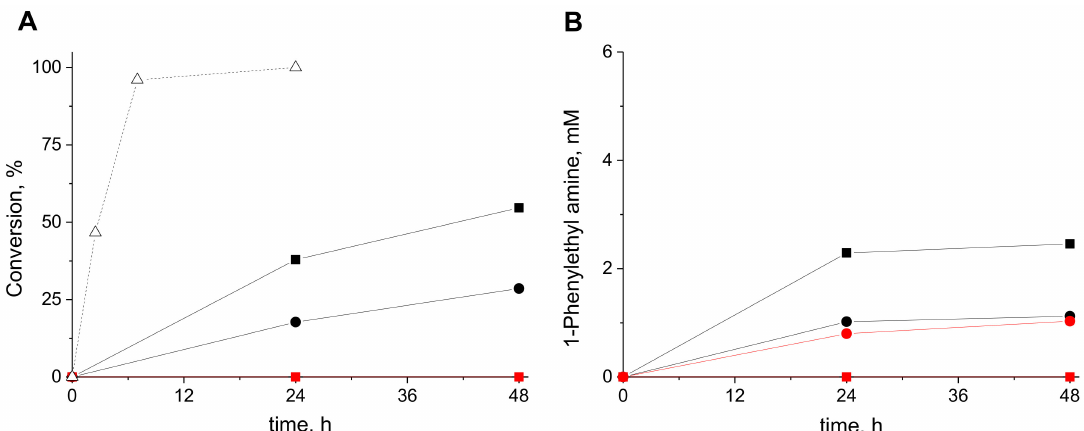
Figure 2. Results of the direct amination of 1-phenylethanol ( 5a ) in a one-pot one-step fashion with SAS ( − ) and g-C 3 N 4 ( − ) photocatalysts, employing BM ω TA ( Bacillus megaterium ω TA (cid:4) / (cid:4) ) and AT ω TA ( Aspergillus terreus ω TA • / • ) enzymes. ( A ) Conversion of 5a . As a comparison, the conversion of 20 mM 5a in MilliQ water containing 0.75 mM SAS is also shown ( (cid:52) ); ( B ) Production of 1-phenylethyl amine 5c . Reaction conditions: 1 mL reaction mixture containing sodium phosphate (NaPi) buffer (100 mM, pH 9), [1-phenylethanol] = 15 mM, [SAS] = 0.75 mM, [isopropylamine, IPA] = 1 M, [Pyridoxal-5-phosphate, PLP] = 1 mM, [crude cell extract overexpressed with ω -TA enzyme] = 10 mg/mL. Reaction mixtures were incubated at 30 ◦ C, irradiated with white light ( λ > 400 nm).